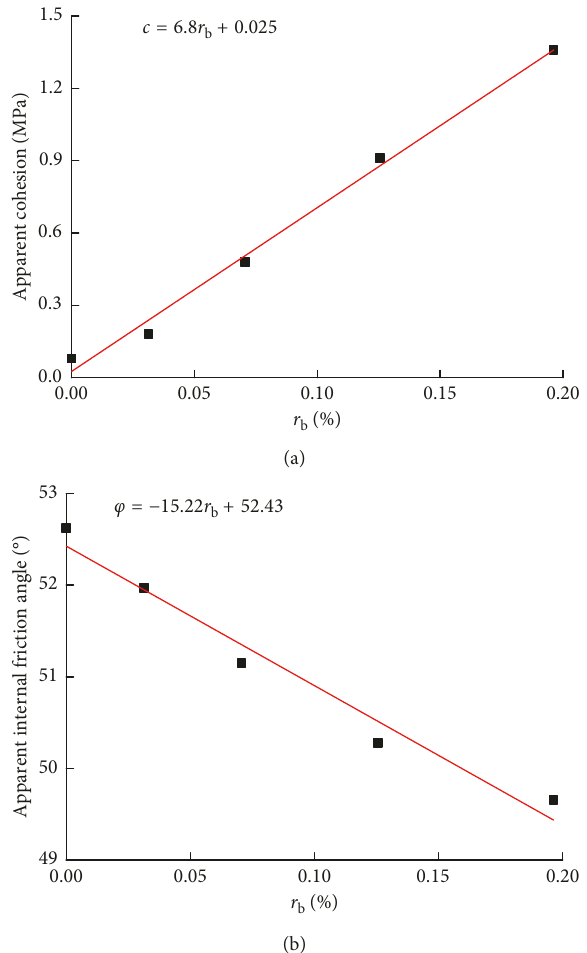
Figure 11: Two shear resistance components of concrete blocks with different r b in residual shear slip stage. (a) Apparent cohesion; (b) apparent internal friction